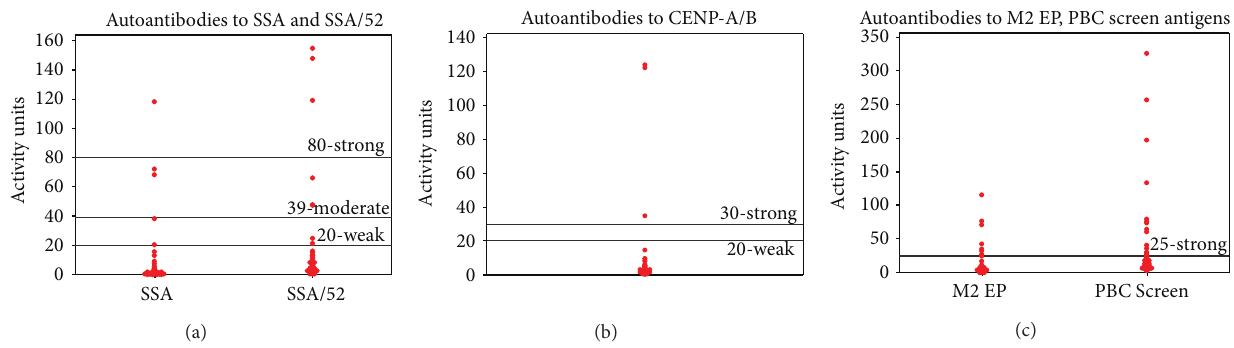
Figure 5: Dot plots of detectable autoantibodies in participant serum measured in activity units with labels for clinical cutoffs. Note: In clinical practice, there are no “moderate” positive readings for CENP-A/B; there are no “weak” or “moderate” positive readings for M2 EP and the PBC Screen.